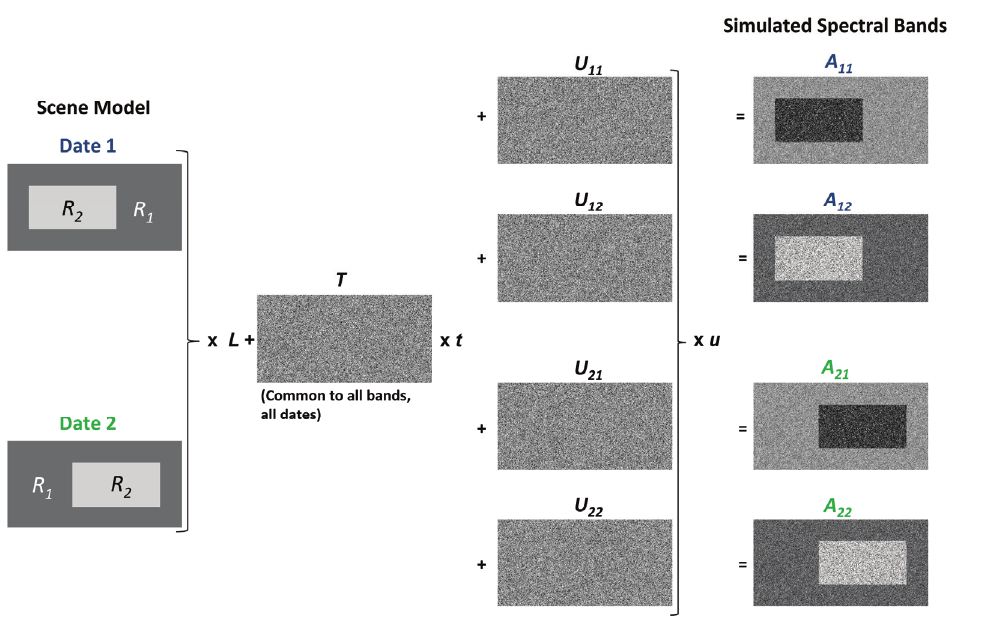
Figure 2. Schematic outline of the process of construction of a two-class, two-band simulated data